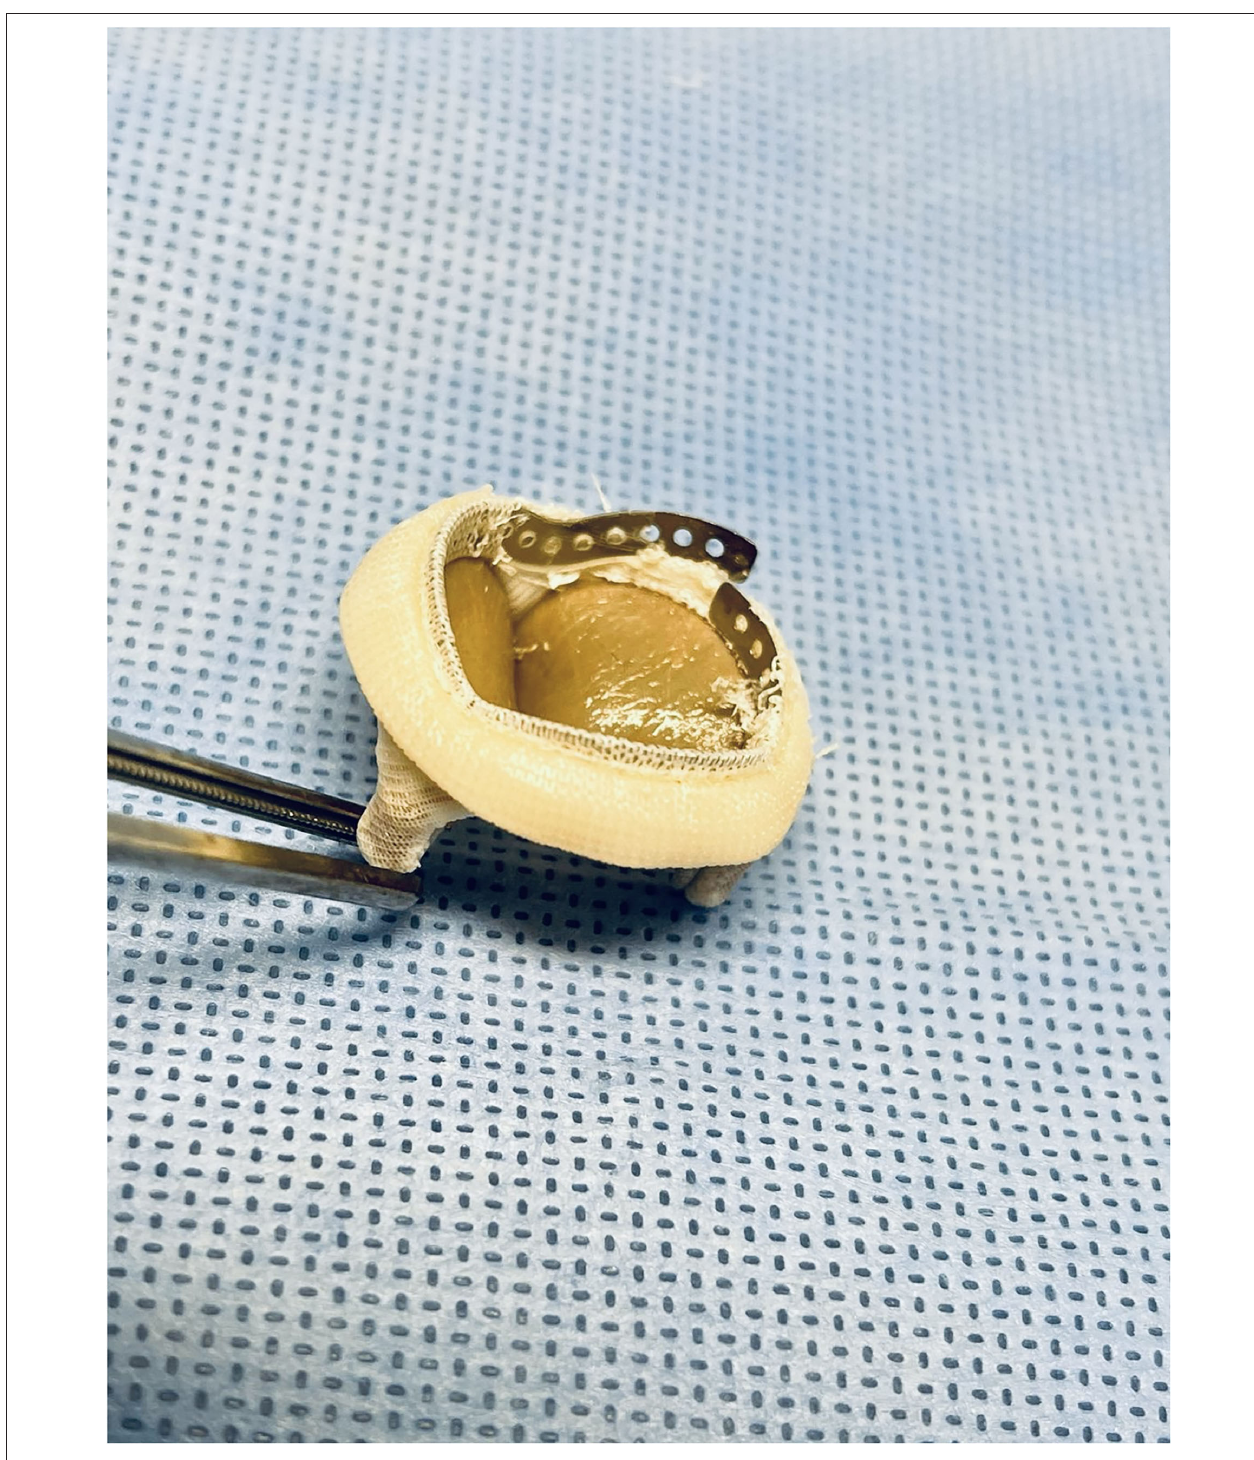
FIGURE 3 | Visual confirmation of bioprosthetic valve fracturing after removal of the sewing ring.